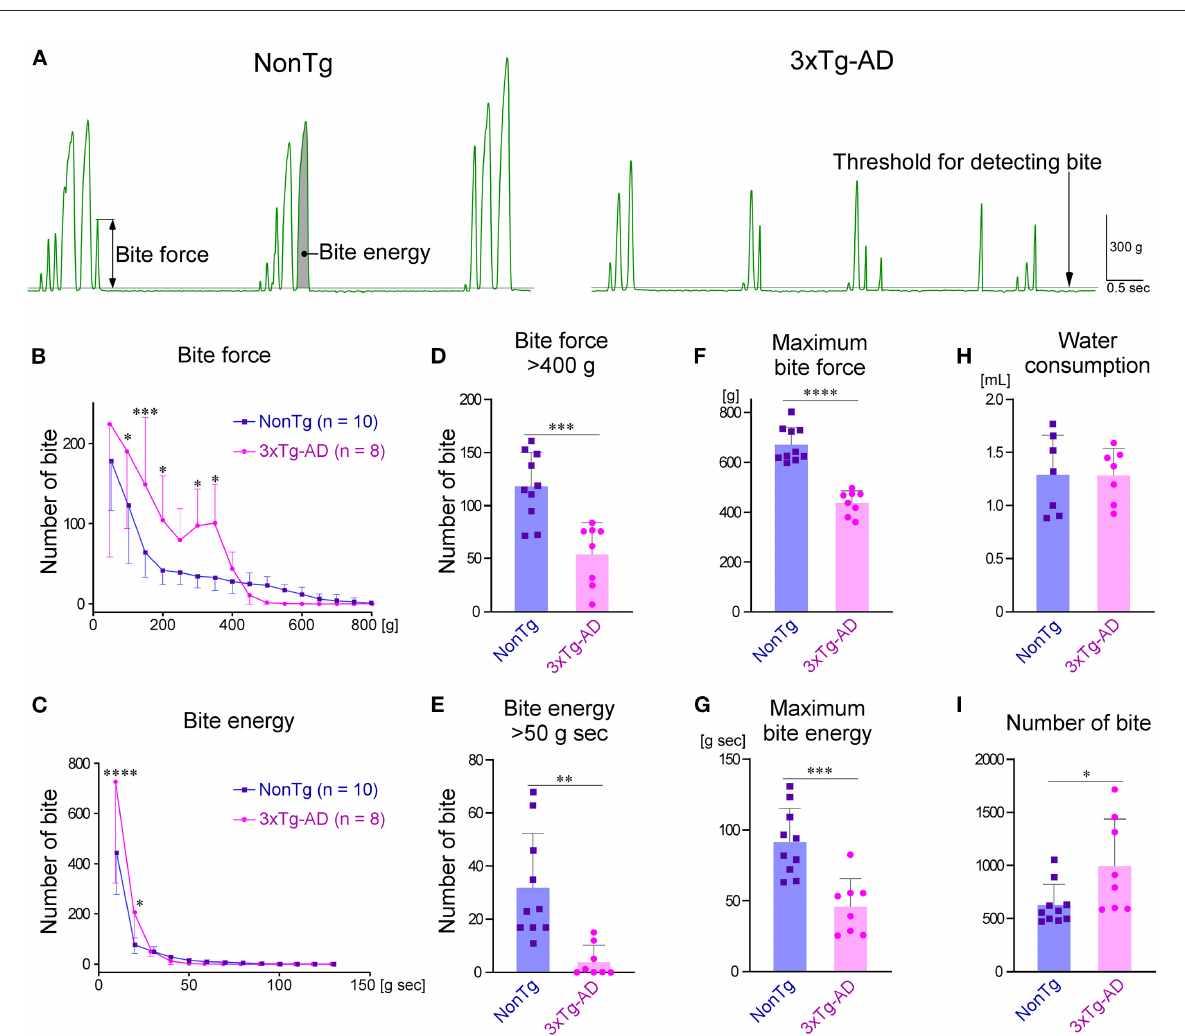
FIGURE5 Comparison of bite force between 3–4-month-old NonTg and 3 × Tg-AD mice when chewing bite bars. (A) Representative raw bite force recordings of a NonTg mouse and a 3 × Tg-AD mouse. The details of how each parameter was measured are provided in the Section Materials and methods. The distribution of bite force during the 30-min measurement was significantly different between 3 × Tg-AD and NonTg mice at bite forces of 100–200g and 300–350g ( B ; P = 0.0192 at 100g, p = 0.0008 at 150g, p = 0.0396 at 200g, p = 0.0353 at 300g, and p = 0.0163 at 350g by Bonferroni multiple comparison tests). In addition, the distribution of bite energy during the 30-min measurement was significantly different at bite energies of 10–20g sec ( C ; p < 0.0001 at 10g sec, and p = 0.0194 at 20g sec by Bonferroni multiple comparison tests). Compared with 3 × Tg-AD mice, NonTg mice had a significantly higher frequency of occlusions with a bite force of more than 400g ( D ; *** p = 0.0005, two-tailed unpaired t -test) and bite energy of more than 50g sec ( E ; ** p = 0.0018, two-tailed unpaired t -test). Furthermore, the maximum bite force ( F ; **** p < 0.0001, two-tailed unpaired t -test) and maximum bite energy ( G ; *** p = 0.0005, two-tailed unpaired t -test) were significantly greater in NonTg mice than in 3 × Tg-AD mice. Although there was no difference in the amount of water consumed during the 30-min measurement between 3 × Tg-AD and NonTg mice ( H ; p = 0.9737, two-tailed unpaired t -test), the number of bites was significantly higher in 3 × Tg-AD mice ( I ; * p = 0.0307, two-tailed unpaired t